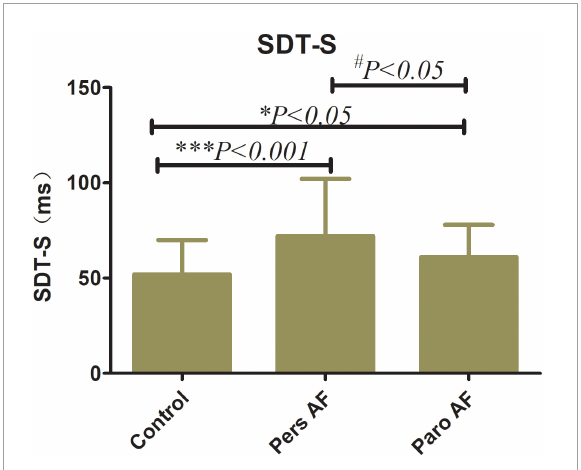
FIGURE5 Comparison of SDT-S among control subjects and subjects with different types of AF SDT-S, SD of time to peak longitudinal strain of all 12 segments SDT-S (52 ± 18 ms in controls, 61 ± 17 ms in Paro AF, and 70 ± 28 ms in Pers AF) vs. Control, ∗ P < 0.05, ∗∗∗ P < 0.001; vs. Pers AF, # P <